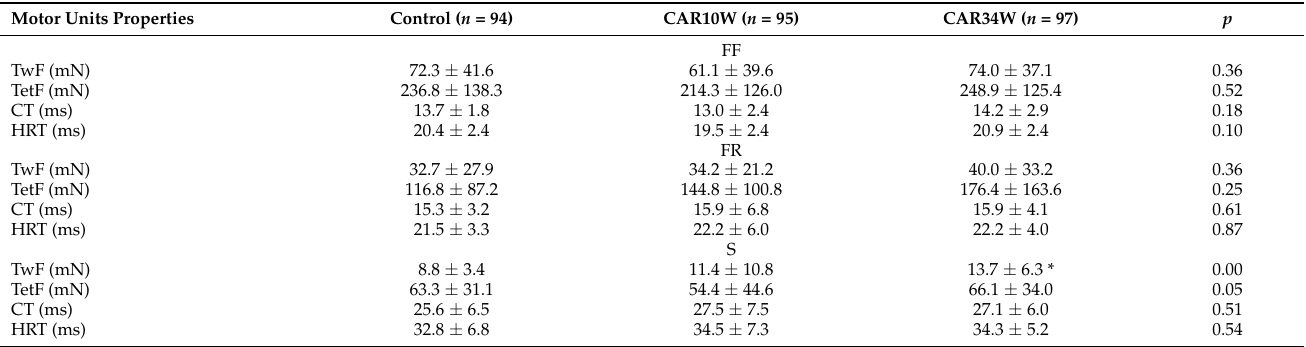
Table 1. Contractile properties of sampled motor units of the left medial gastrocnemius muscle in CON ( n = 6), CAR10W ( n = 8), and CAR34W ( n = 8) rats. Motor Units